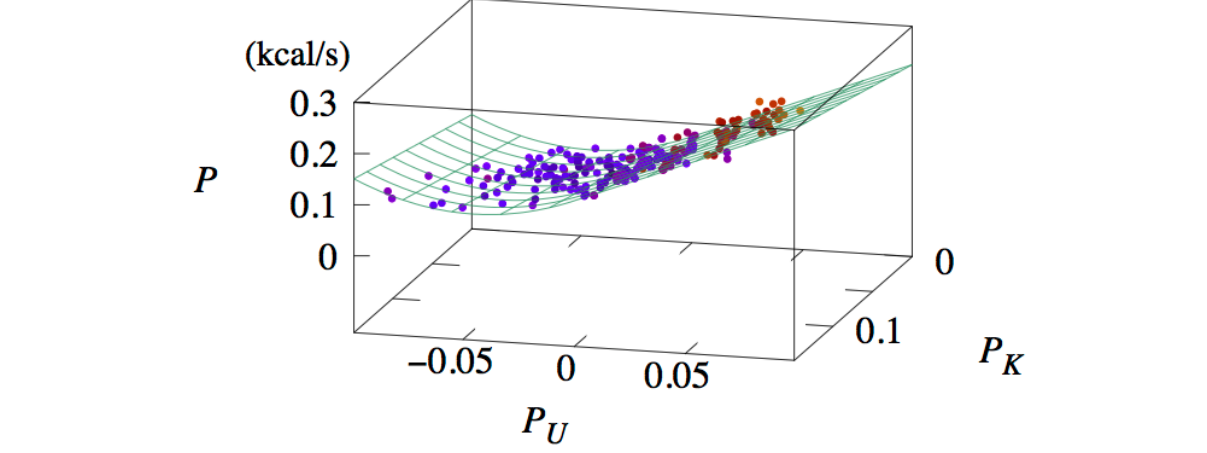
Figure 6. Three-dimensional scatterplot of data (dots) and model prediction (lines) of P versus PU and PK for men.